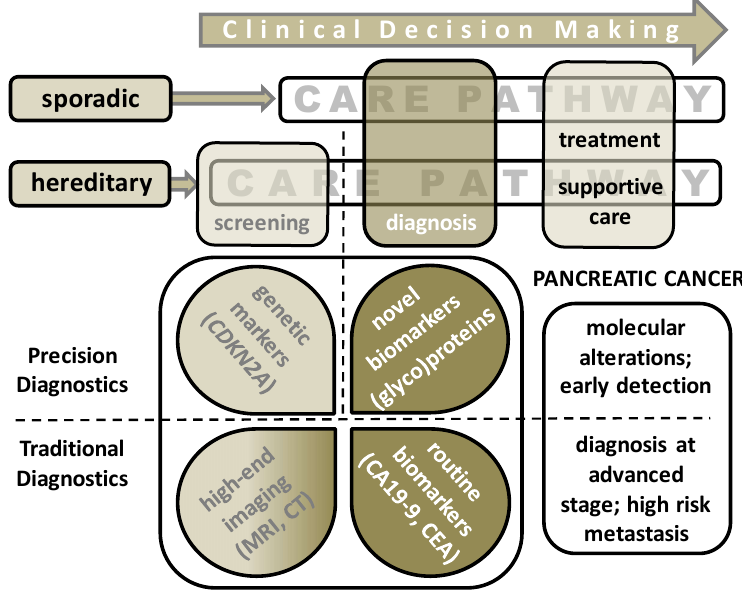
Figure 1. Clinical decision making pathway depicted for sporadic pancreatic ductal adenocarcinoma (PDAC) patients and individuals with a hereditary background (family history or gene mutation carriers). Surveillance of the latter group was performed with high-end imaging approaches such as MRI and EUS. Diagnosis of PDAC is commonly based on the same imaging technology combined with current routine markers, with the aid of cytology and histology diagnostics as is discussed in this review. Various ongoing approaches are summarized that search for novel (glyco)protein biomarkers.